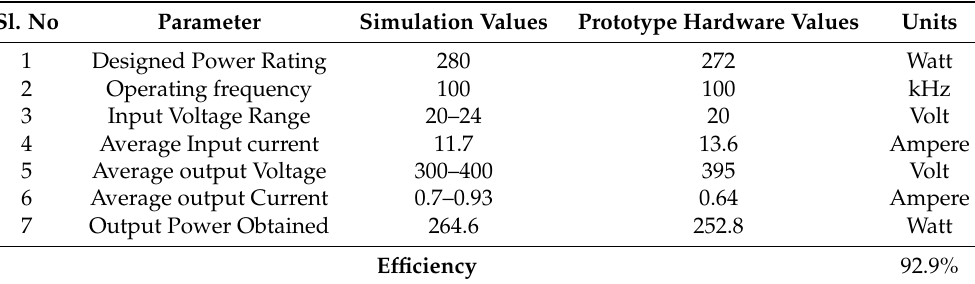
Table 4. Comparison of combustion engine vehicles and electric